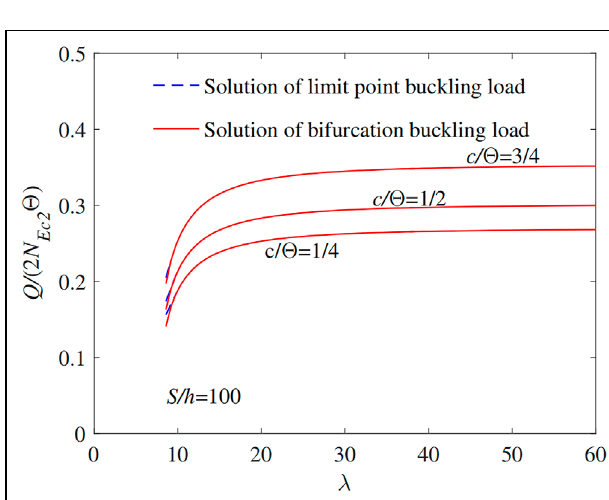
FIGURE 11 | The limit point instability and bifurcation for pin-ended FGM arches having different localized